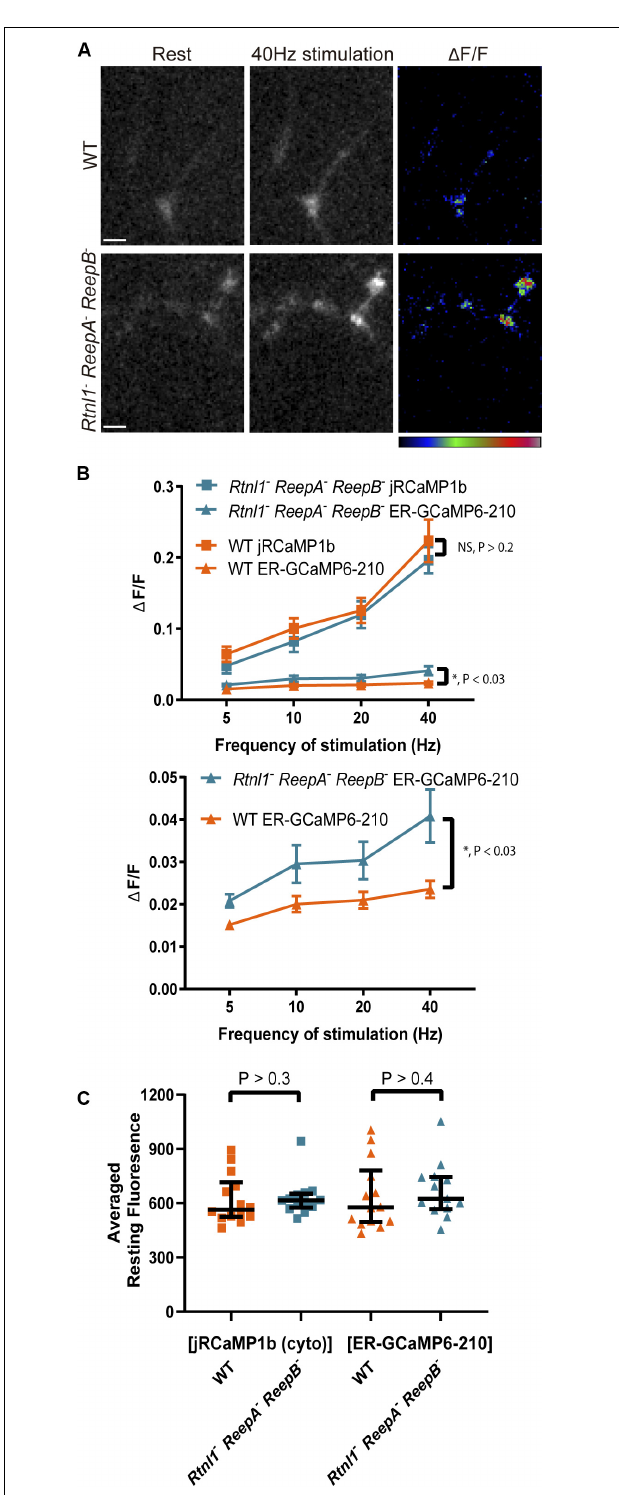
FIGURE 4 | ER lumenal, but not cytoplasmic, responses were significantly increased in Rtnl1 - ReepA - ReepB - mutant Type Ib boutons compared to WT , with no difference in resting fluorescence intensity. (A) Lumenal ER-GCaMP6-210 expressed in aCC using Dpr-GMR94G06-GAL4 showed